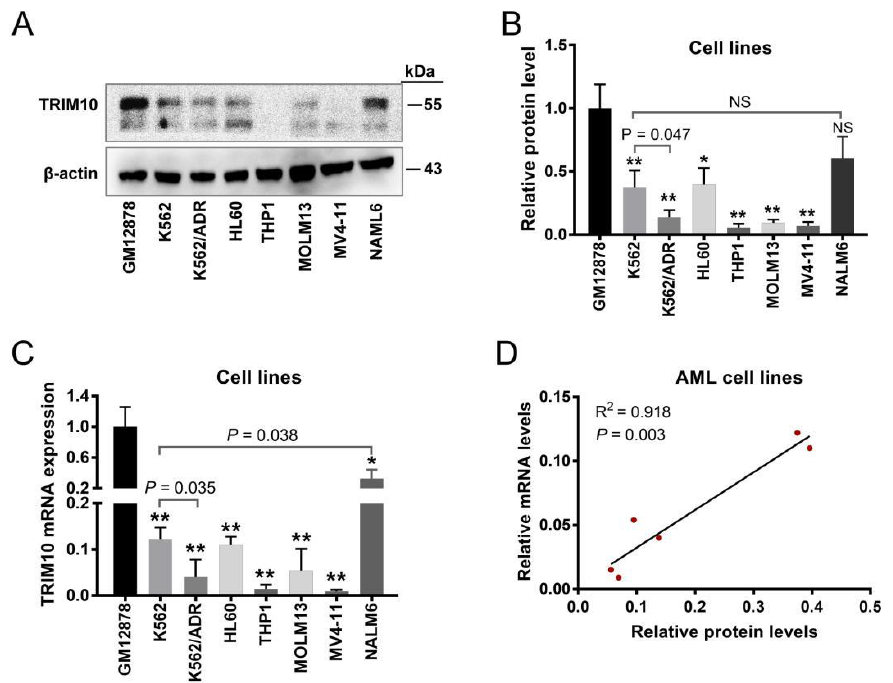
Figure 2. TRIM10 is downregulated in AML cell lines. ( A ) Western blot analysis of TRIM10 expres- sion in AML cell lines. ( B ) Statistical analysis of TRIM10 protein expression in 6 AML cell lines for three experiments. ( C ) Analysis of TRIM10 mRNA expression in the 6 AML cell lines with qRT-PCR. ( D ) Pearson correlation analysis for mRNA and protein expression of TRIM10 (Pearson r = 0.918, p = 0.003, with F test). The human lymphocytic leukemia cell line NALM6 and the human normal hematopoietic cell line GM12878 were used as the control groups. * p < 0.05; ** p < 0.01 (Student’s t - test).